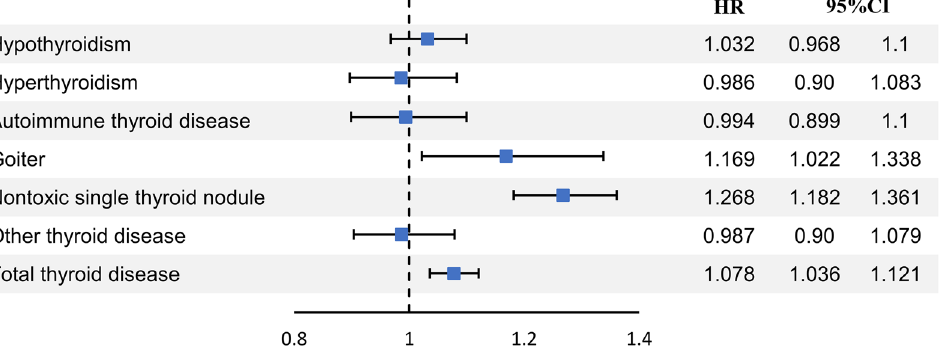
Figure 2. Conditional logistic regression analysis of thyroid disease in women with uterine fibroids from the HIRA data (after